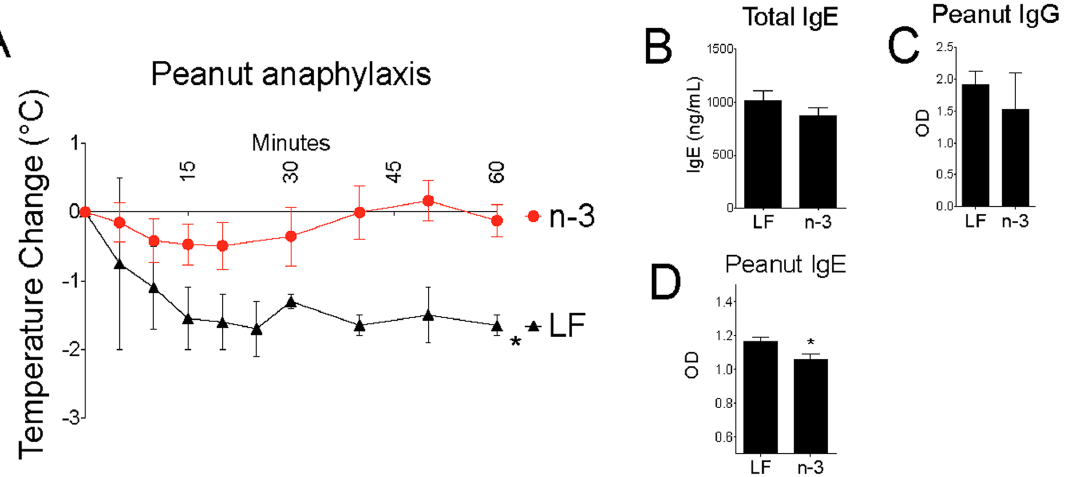
Figure 3. High omega-3 intake altered allergic responses. (a–d) Weaned male BALB/c pups were gavaged with peanut protein and cholera toxin weekly for 4–8 weeks before challenge. Temperature drop after intraperitoneal challenge (a), total IgE (b), and peanut-specific antibodies (c and d) (n=5). LF, Low Fat; n 2 3, Omega-3 diet. Results are representative of 2 or more (b-d) or combined from two (a) independent experiments and displayed as mean + s.e.m. Significance determined by t test. n designates mouse number per group per